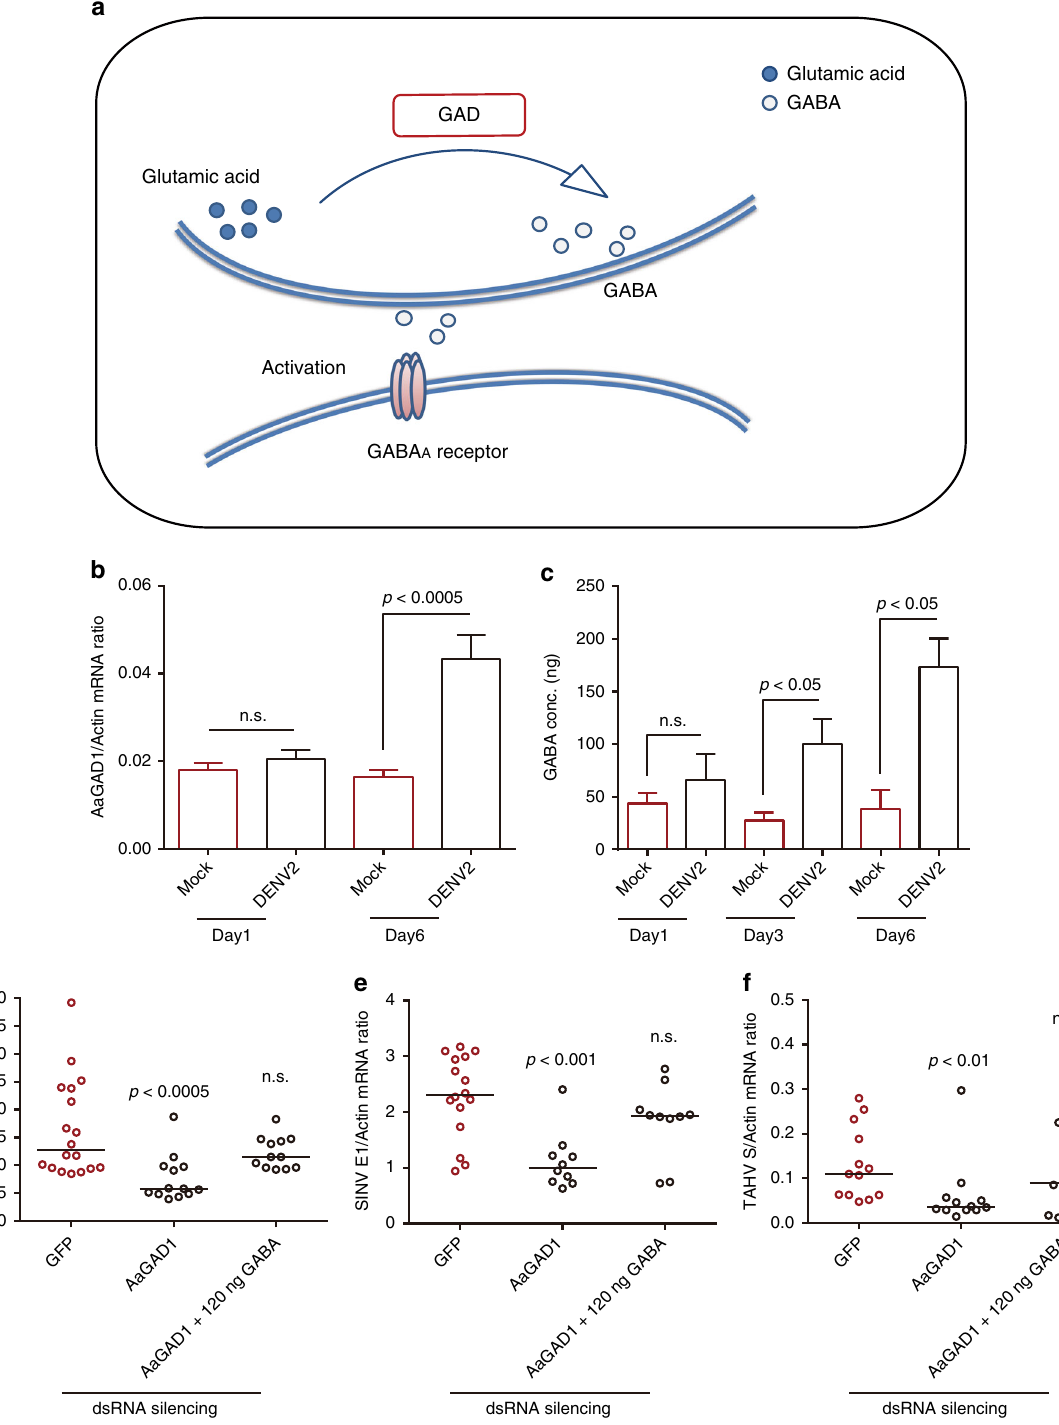
Fig. 3 Role of the GABA production system during infection with mosquito-borne viruses. a Schematic representation of the GABAergic system. b , c GABA generation was induced by DENV-2 infection in A. aegypti . b The expression of AaGAD1 was enhanced by DENV-2 infection. The abundance of AaGAD1 was assessed by SYBR Green qPCR on 1 and 6 days post-infection. c GABA induction by DENV-2 infection in A. aegypti . Ten M.I.D. 50 of DENV-2 were inoculated into the thoracic region of mosquitoes. Mosquitoes that were microinjected with PBS served as mock controls. The data are presented as the mean ± s.e.m. The results were reproduced three times. d – f Role of the GABA production system during infection with mosquito-borne viruses. AaGAD1 was silenced by inoculation with AaGAD1 dsRNA. Mosquitoes inoculated with GFP dsRNA served as negative controls. Three days post dsRNA treatment,